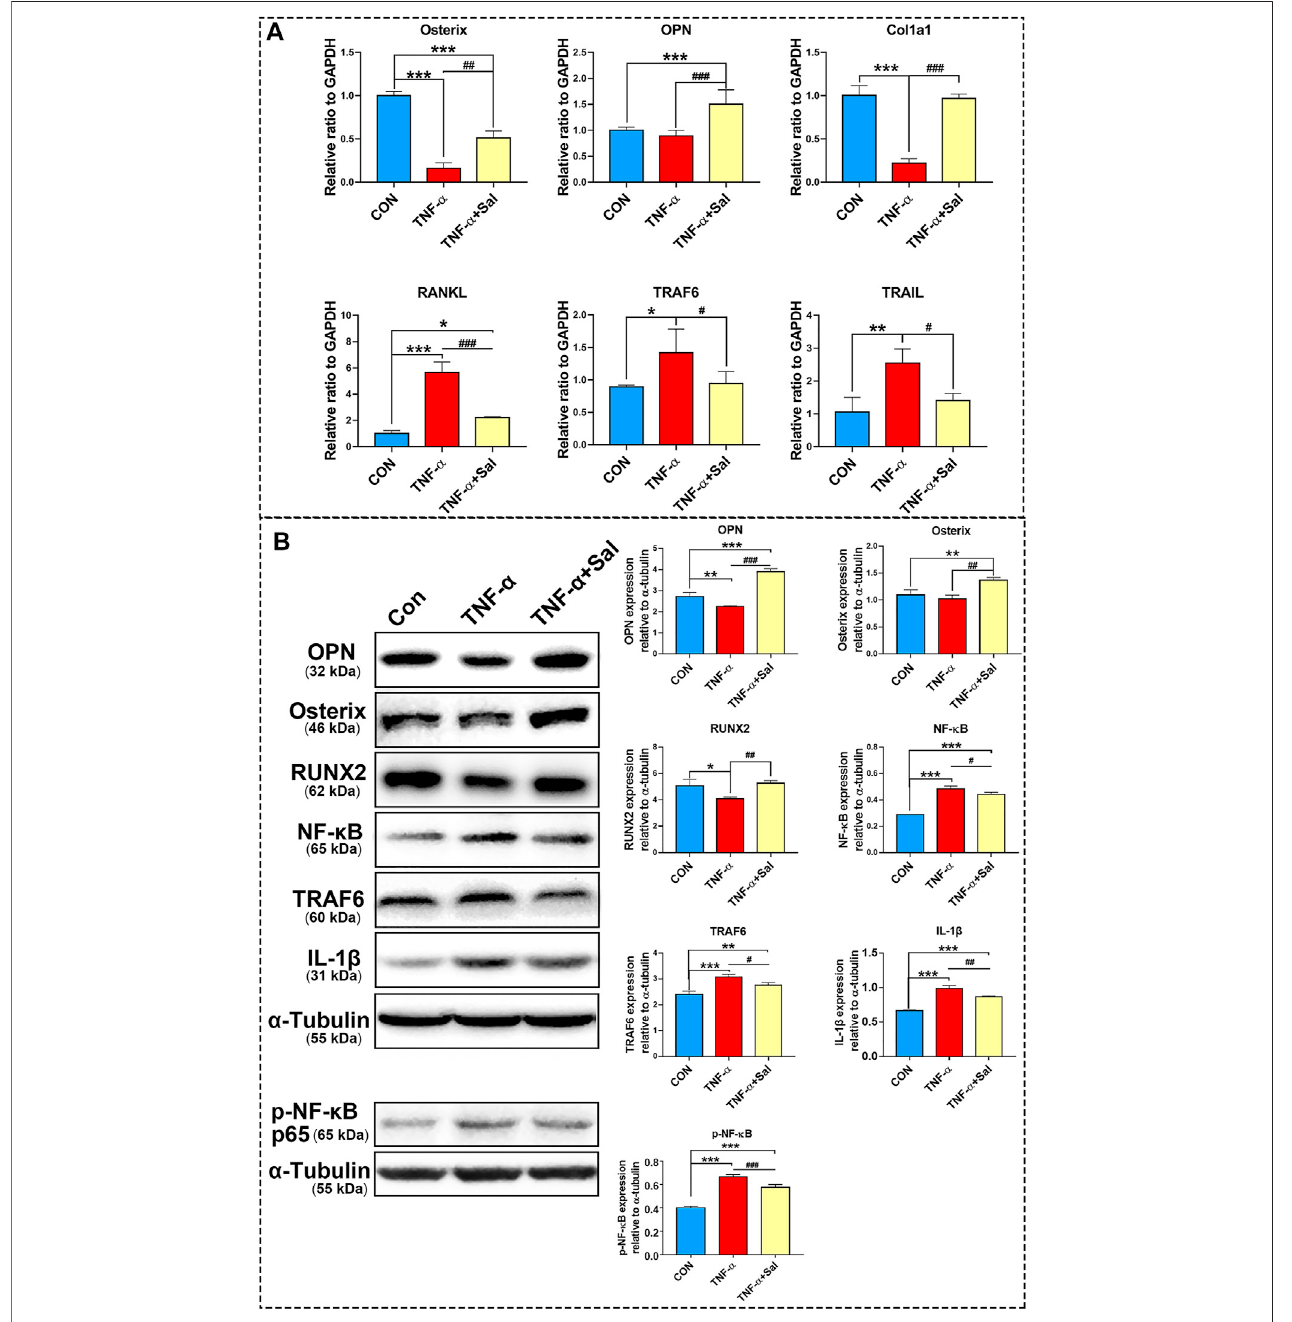
FIGURE 5 | The impacts of salvianolate treatment on TNF- α -induced MC3T3-E1 cells. (A) Osterix, OPN, Col1a1, RANKL, TRAF6, and TRAIL gene expression in TNF- α -inducedMC3T3-E1cellsaftersalvianolatetreatmentbasedonRT-PCRanalyses. (B) OPN,RUNX2,NF κ B,TRAF6,IL-1 β ,andp-NF- κ Bp65proteinexpressionin TNF- α -induced MC3T3-E1 cells after salvianolate treatment based on western blot analyses. * p < 0.05, ** p < 0.01, *** p < 0.001 vs. CON, # p < 0.05, ## p < 0.01, ### p < 0.001 vs. TNF- α .